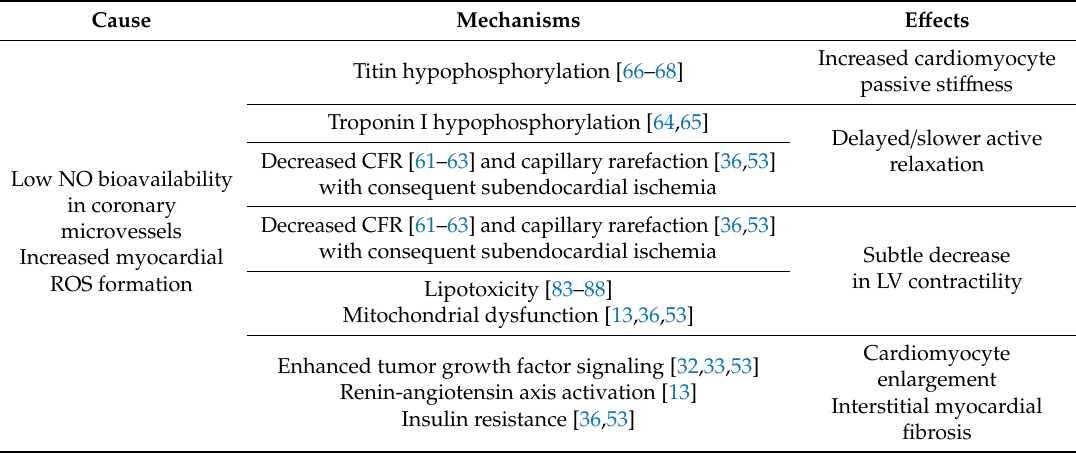
Table 1. Consequences of endothelial dysfunction in patients with